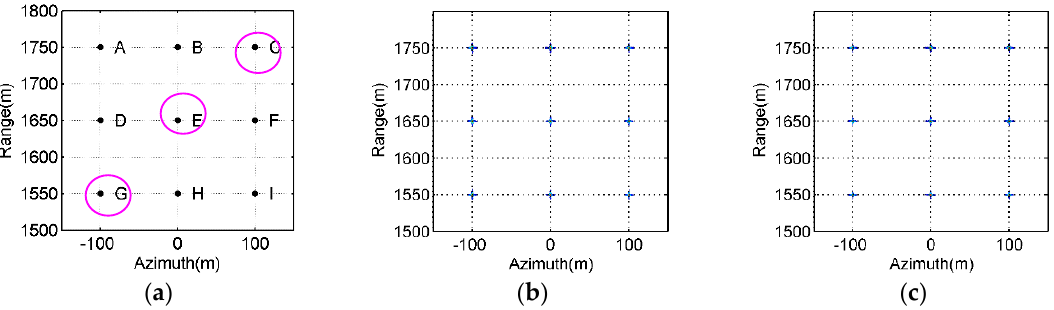
Figure 8. Imaging results of the simulated data obtained by the different algorithms. ( a ) Distribution of the point-like scatterers; ( b ) Bistatic DTAD; ( c ) Proposed ETDA.